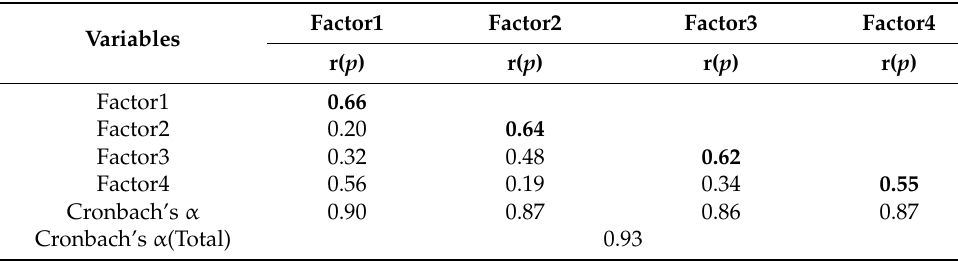
Table 4. Correlation Matrix and Reliability of K-C19P